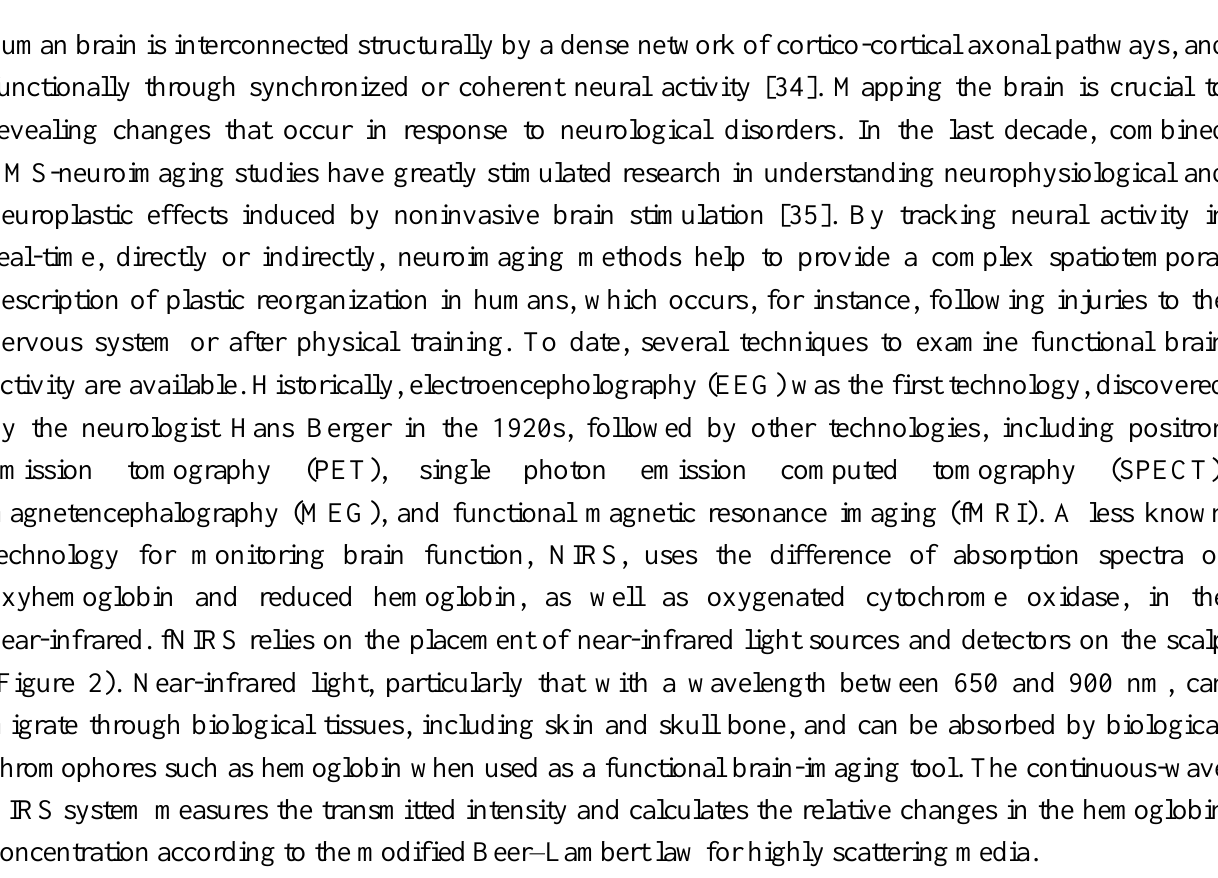
Figure 2. Measurement of cortical activity with near-infrared spectroscopy